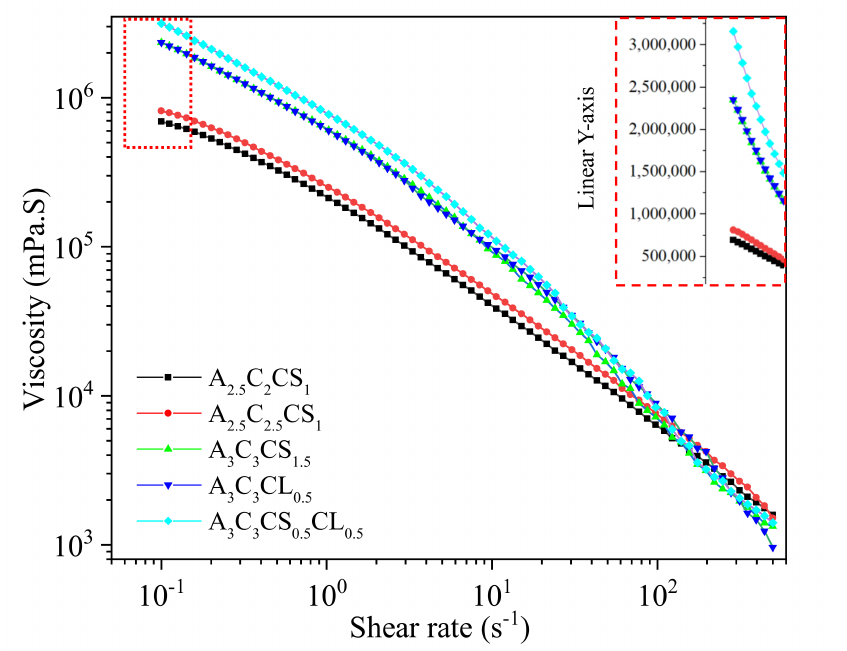
Figure 4. Viscosities of various compositions with respect to the shear rate. Each data point was calculated averaging three sample